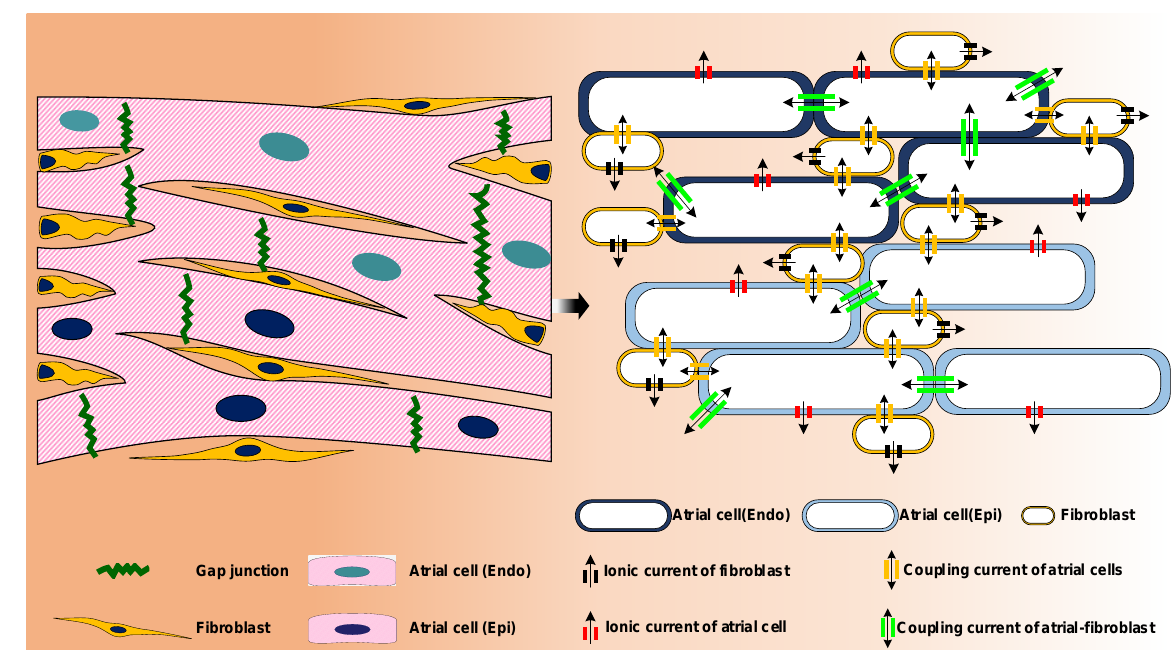
Figure 8. Schematic overview of modelling of atrial tissue. A computational model of the 2D human atrial tissue considered atrial cells, inherent electrical heterogeneity between the endocardial (Endo) and epicardial (Epi) myocytes [99], fibroblast-myocyte coupling, cell-cell coupling via gap junction, the distribution of different cells and fibrosis etc.